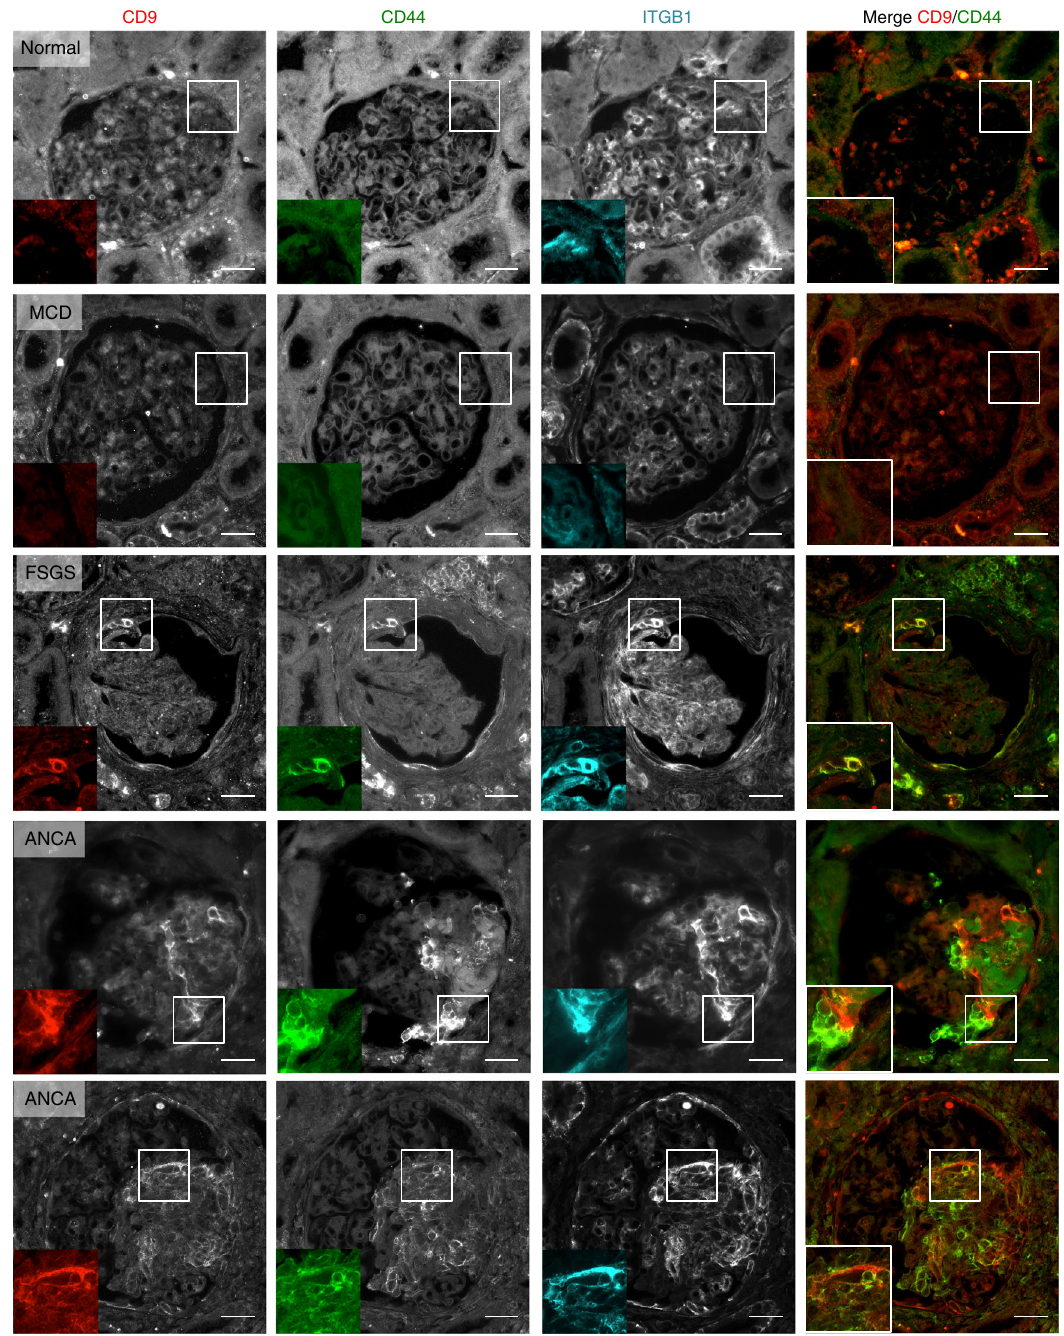
Fig. 7 In human, CD9 overexpression in pathological glomeruli is associated with CD44 and ITGB1 expression. Representative images of immuno fl uorescent stainings of CD9 (left panel), CD44 (second panel), ITGB1/ β 1 integrin (third panel), and merge for CD9 (red) and CD44 (green) expression (right panel) on glomeruli from pathological human tissues. Scale bar, 50 µ m. Higher magni fi cations are shown in the insets. MCD minimal change disease, FSGS focal segmental glomerulosclerosis, ANCA ANCA vasculitis. Source data are provided as a Source Data fi Bone marrow transplantation . Recipient mice were exposed to 9.5Gy Cesium 137 under the control of the selective PEC promoter (pPEC-rtTA-M2 mice) with mice radiation for 10 min. The day after, each mouse received 10 ×10 6 bone marrow expressing CRE recombinase under the control of an inducible promoter (tetracycline-responsive element). Doxycycline hyclate (Sigma Aldrich) was administered in drinking water for 14 days (5% sucrose and 1mg/ml doxycycline) followed by 1 week of washout. Age-matched littermates that had no deletion of Cd9 in any cells were considered as controls. Animals were housed under standard speci fi c pathogen-free conditions. All animal procedures were performed in accordance with guidelines of the European Community (L358 – 86/609EEC), and were approved by the Institut National de la Santé et de la Recherche Médicale and the Ministry for Higher Education and Research (MESR 7646 and TARGET GLOMDIS).